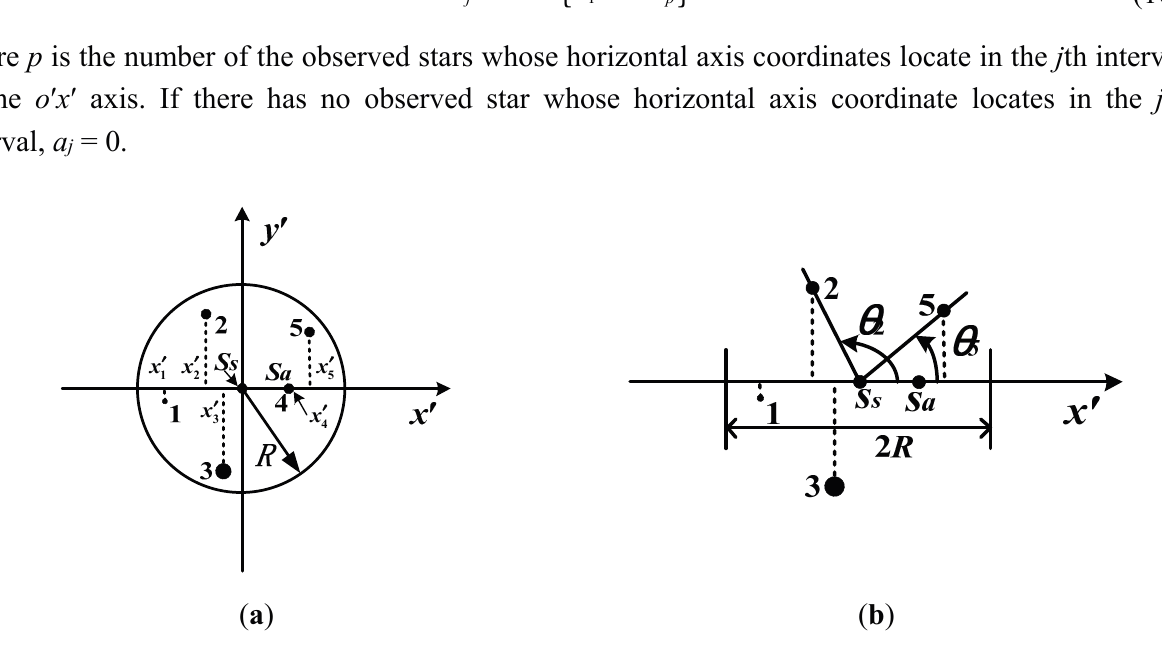
Figure 3. Generation of the one-dimensional vector pattern. ( a ) The positions of the observed stars on o ʹ x ʹ axis; ( b ) The plane included